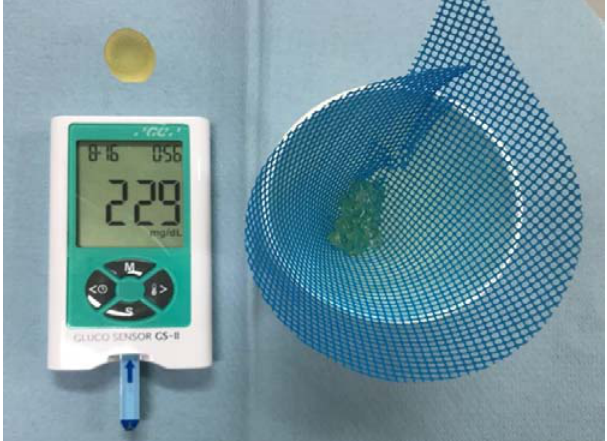
Figure 3. Masticatory performance (MP) measurement system (Gluco Sensor GS–II). The concentration of glucose from the chewed gummy jelly was defined as MP.